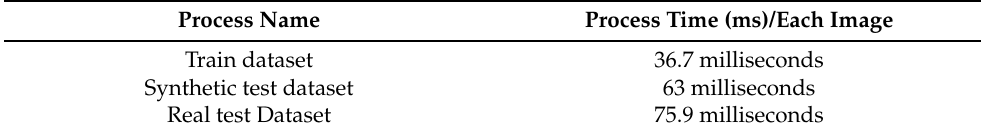
Table 4. The CDNTS layer’s time cost list for the different